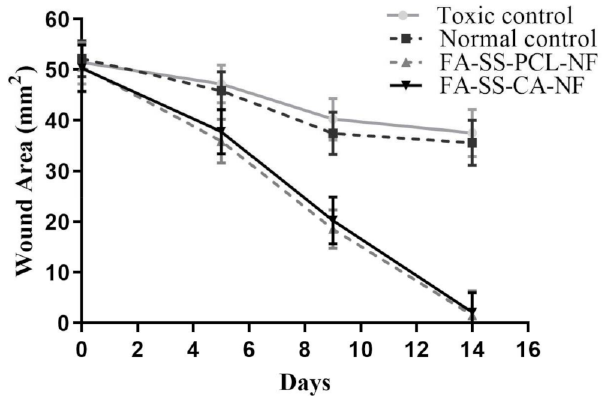
Figure 15. Wound-healing rate for normal control, toxic control, FA-SS-PCL-NF, and FA-SS-CA-NF (mean ±